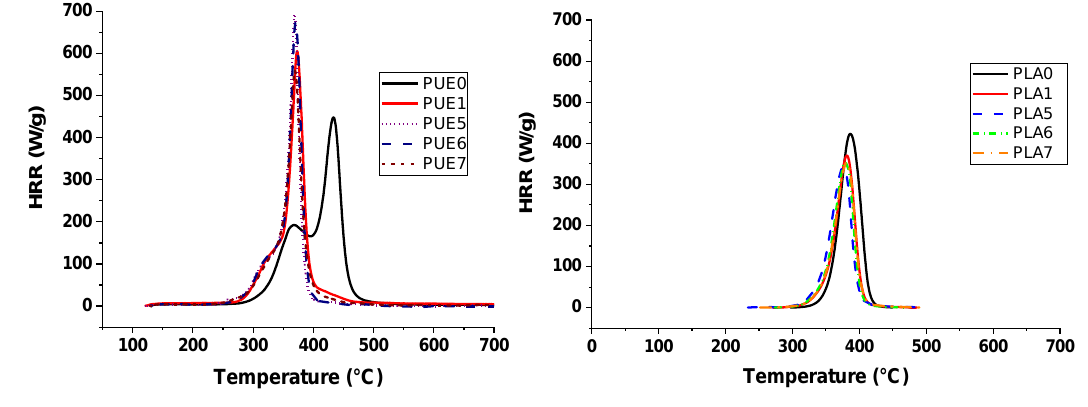
Figure 14. PCFC curves for PUE and PLA/APP/lignin. Table 6. PCFC results for PUE and PLA/APP composites.